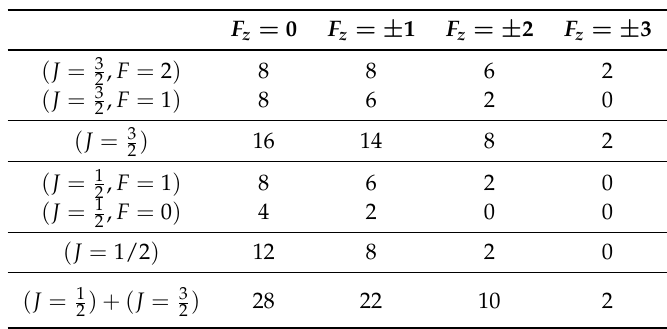
Table 1. Multiplicities in the 6 P 1/2 –6 P 3/2 –1 S system. One might wonder why F z = ± 3 is possible for F = 2. The answer is that F = 2 here refers to the total angular momentum (electron orbital plus electron spin plus nuclear spin) of one of the atoms, while F z = ± 3 refers to the angular momentum projection of the sum of the total angular momenta of both